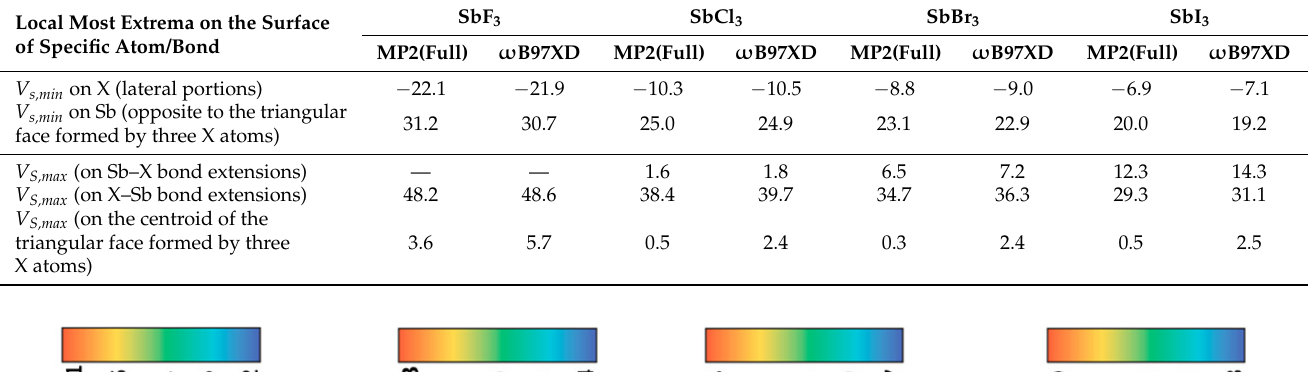
Table 2. Comparison of MP2(full)/def2-TZVPPD level 0.001 a.u. isodensity envelope mapped potentials with those of ω B97XD/def2-TZVPPD potentials computed on the surfaces of the SbX 3 molecules (X = F, Cl, Br, I).